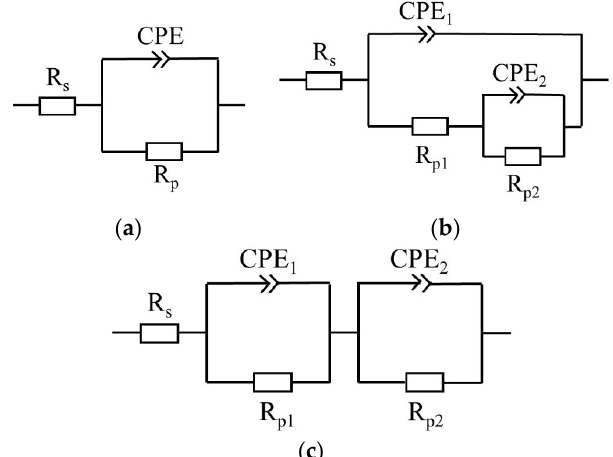
Figure 2. Equivalent circuits used for the analysis of Nyquist diagrams with one capacitive loop ( a ) and two capacitive loops ( b , c